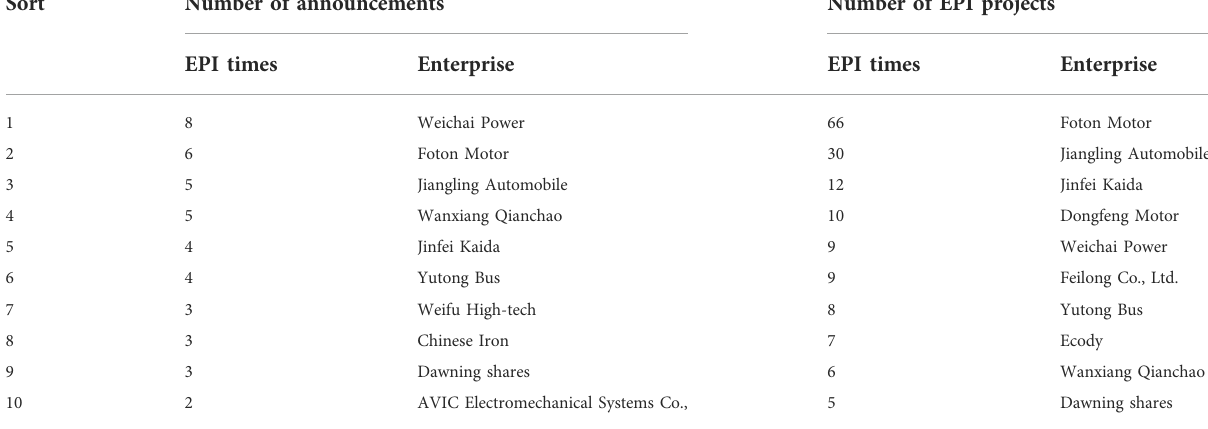
TABLE 10 Number of EPI announcements issued by listed companies in the automobile manufacturing industry.